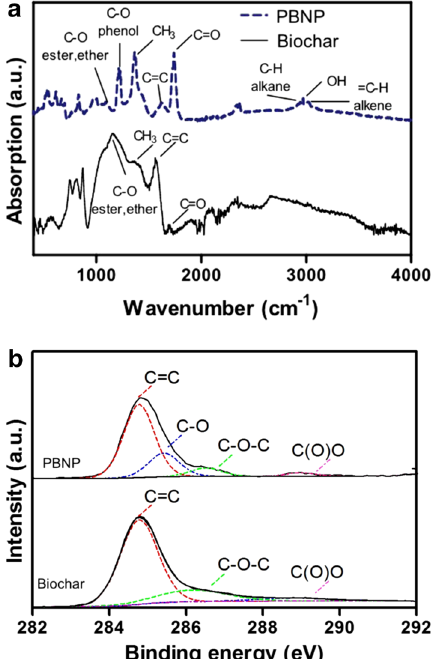
Fig. 3 Fourier transform infrared (FTIR) spectra ( a ) and X-ray pho- toelectron spectroscopy (XPS) analysis ( b ) of bulk mixed wood chip biochar and the extracted BCNPs. (Adapted from Safari et al. (2019) with copyright permission from Springer